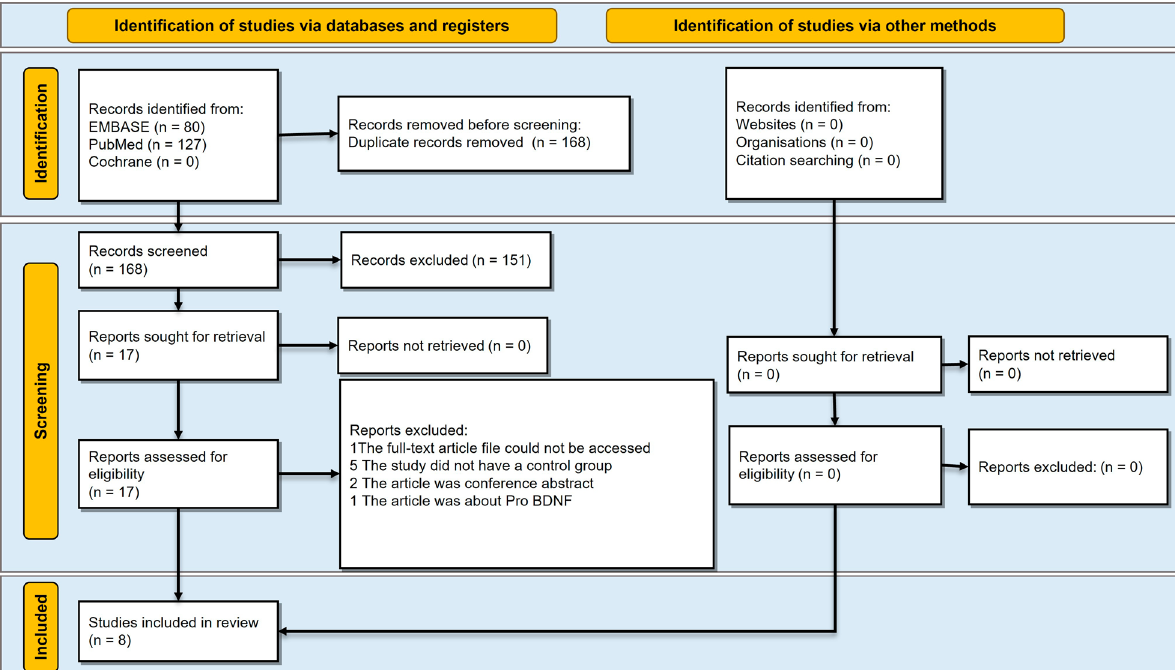
Fig. 1 Flow diagram summarizing the selection of eligible studies based on the PRISMA